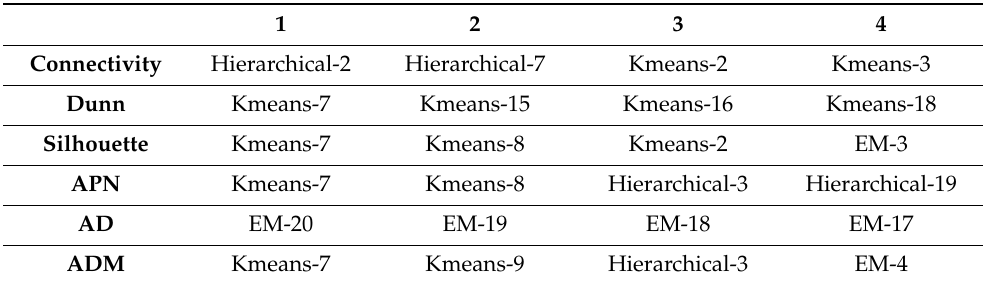
Table 3. Optimal comparison results of the clustering algorithm.